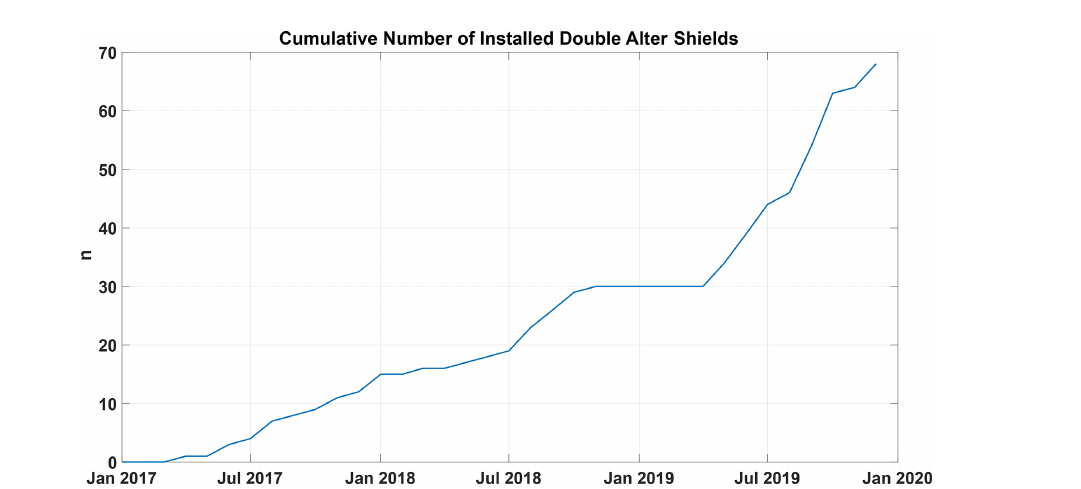
Figure 5. Cumulative total number of Pluvio 2 L double Alter Shield gauges installed in this subset ( n = 397) of stations in the ECCC operational network from January 2017 through December